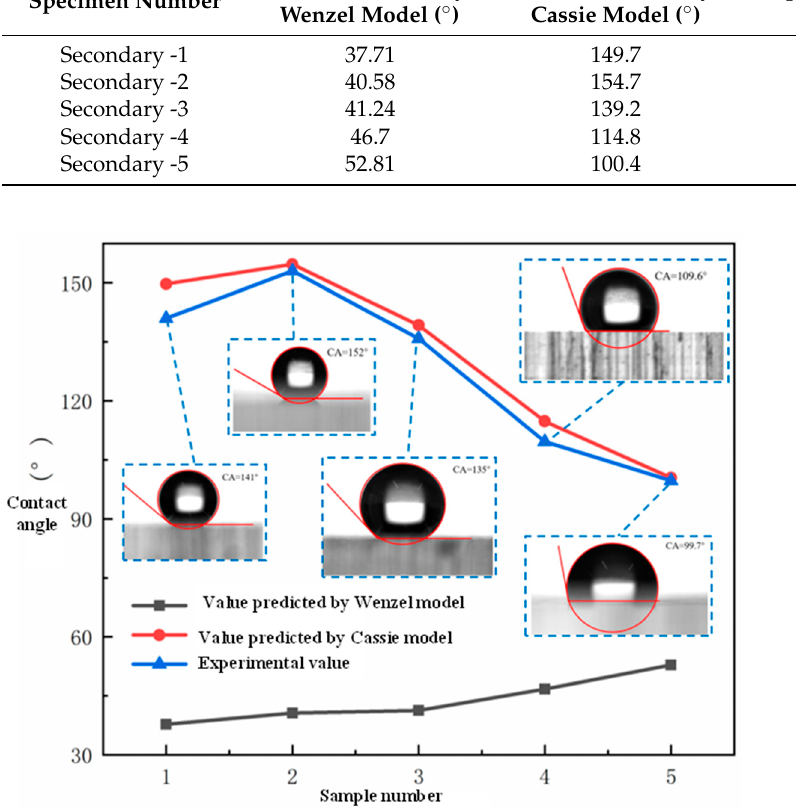
Figure 19. Predicted and experimental contact angles of cruciform secondary microstructures.